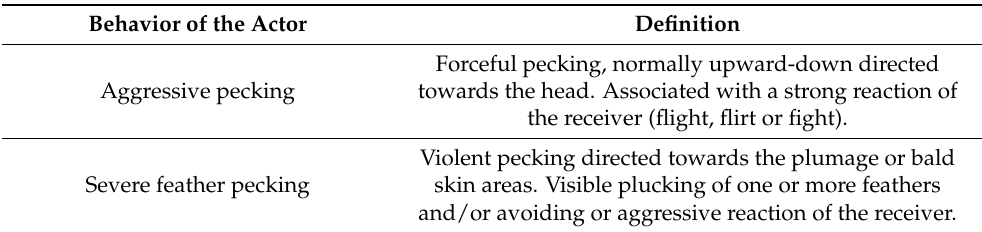
Table 2. Ethogram used for the video analyses, with definitions of the pecking behavior shown by the actor (pecking